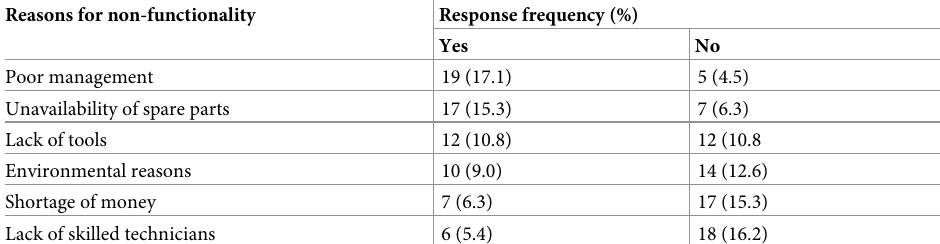
Table 4. Reasons attributed to the non-functional water services other than water